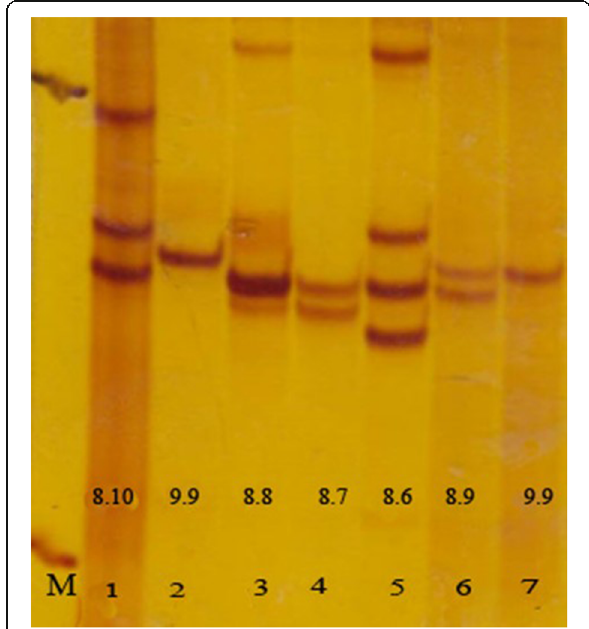
Fig. 1 Ten percent polyacrylamide gel for TAAAA polymorphism association study. The results are shown with a 100-bp DNA marker. Rows (1 – 7) show the allelic variations of the TAAAA repeats in the studied population